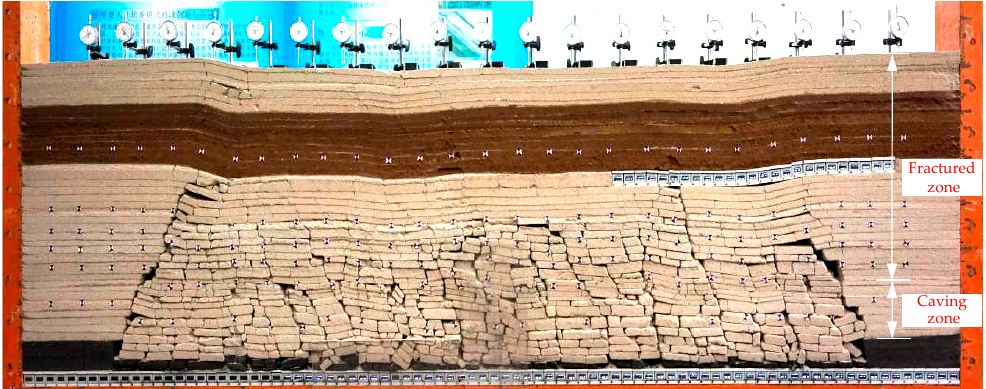
Figure 26. Panorama of the simulated working face after excavation.